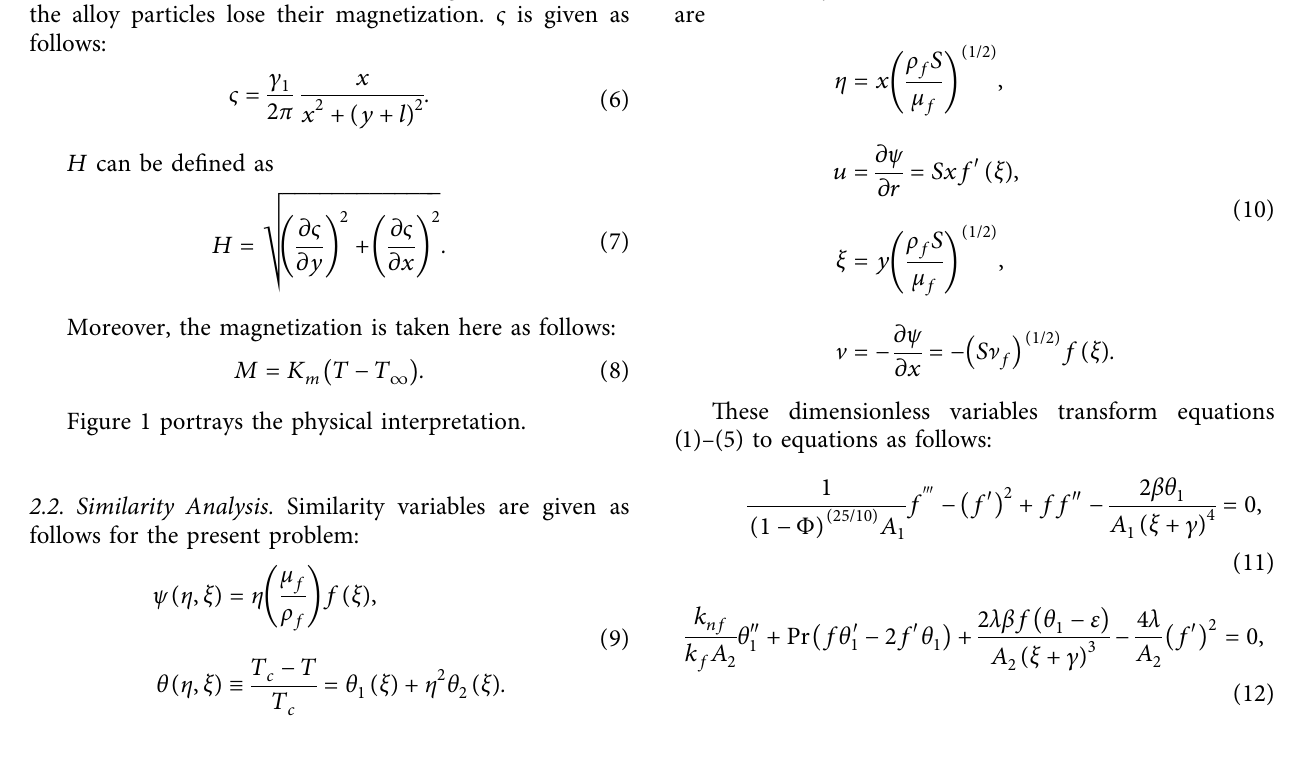
Table 2: Thermophysical expressions of engine oil C